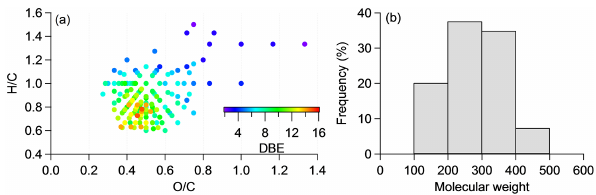
Figure 3. (a) Van Krevelen diagram of common molecules iden- tified in every phenolic aqSOA via nano-DESI MS analysis. Each data point is colored by its DBE value. (b) A frequency histogram of the molecular weight of these common